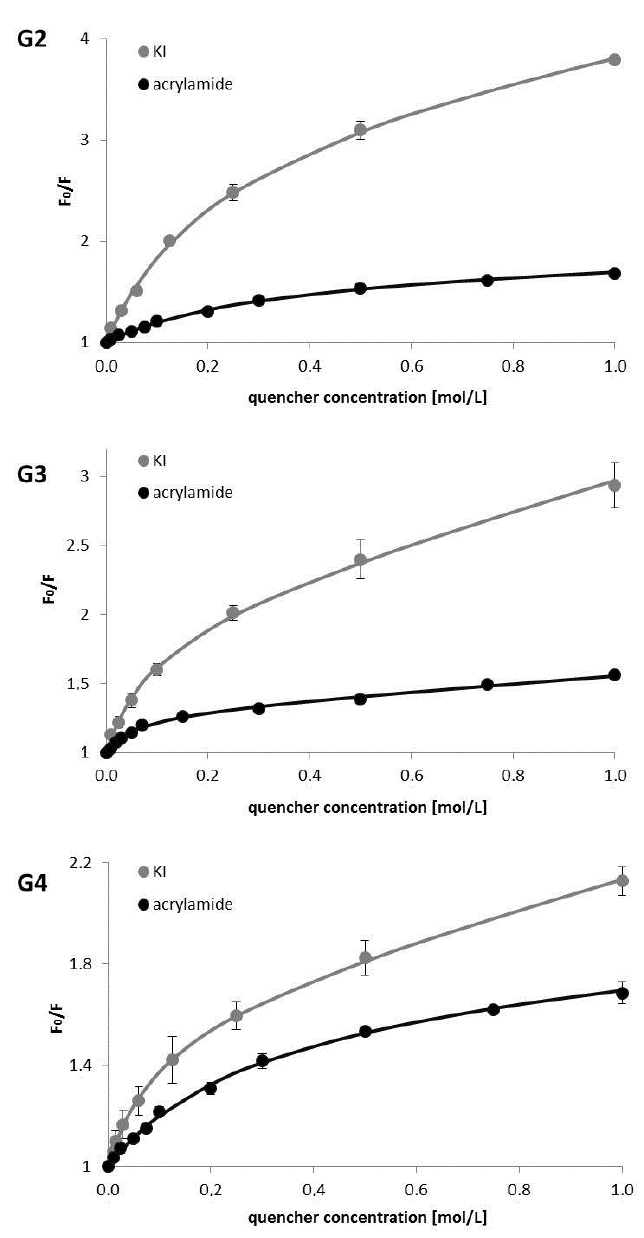
Figure 2. Stern-Volmer plots for PAMAM G2, PAMAM G3, and PAMAM G4 quenched by acrylamide and KI, n = 3. Table 2. Estimated Stern-Volmer parameters.